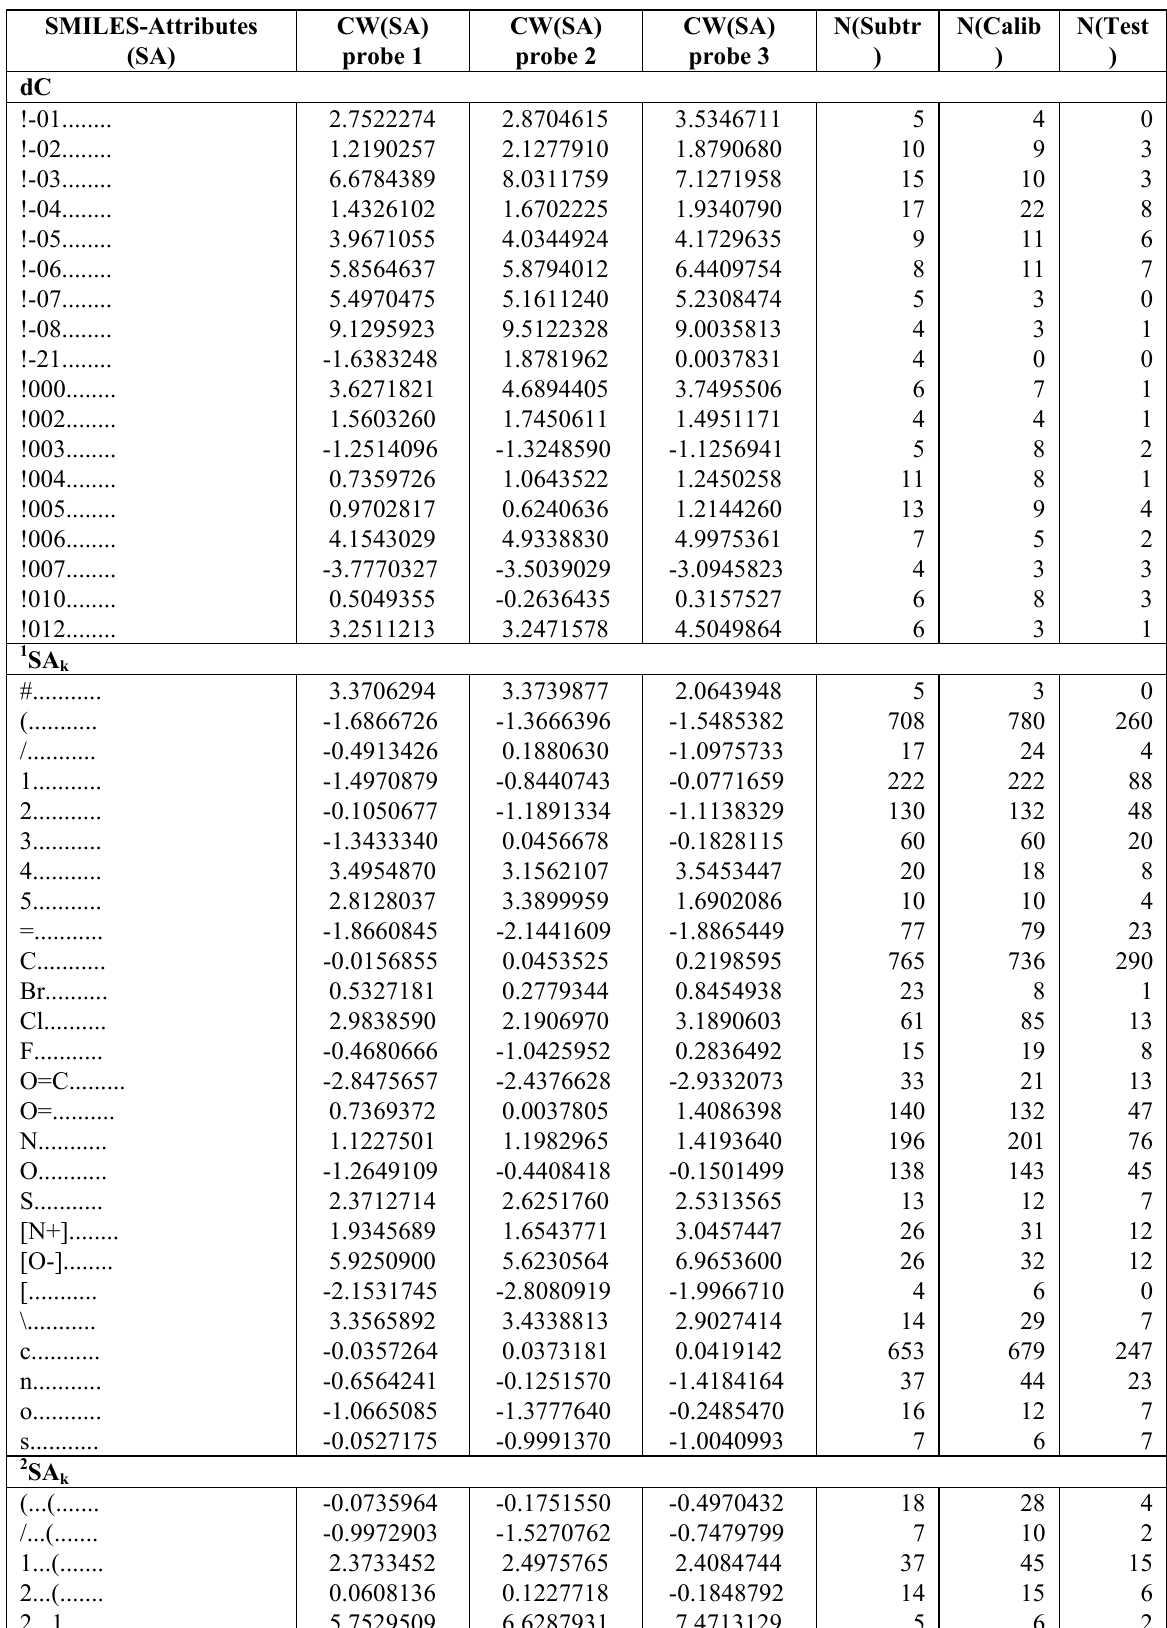
Table 5. Correlation weights for calculation with Equation 1 DCW(4). N(Subtr), N(calib), and N(Test) are numbers of a given SMILES attribute in the subtraining set, calibration set, and test set, respectively. The rare attributes are